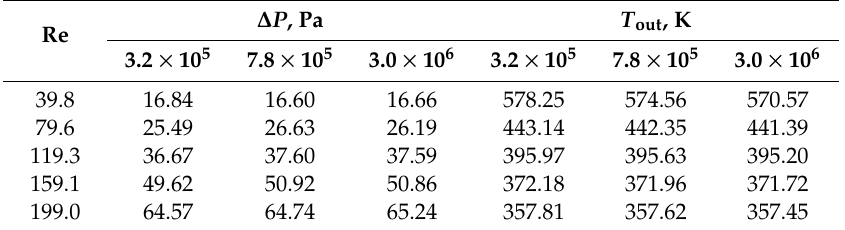
Table 3. The pressure drop and fluid temperature at the outlet with various Reynolds numbers (Re) in the NPFA for di ff erent